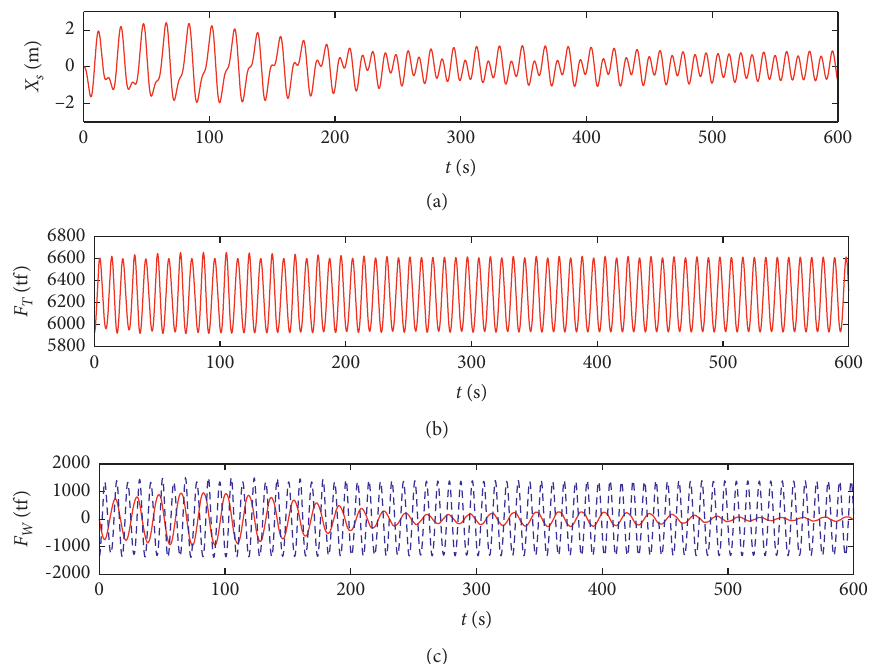
Figure 8: The time history of (a) tube displacement X s , (b) mooring cable tension F T , and (c) wave force F W (the solid line represents horizontal wave force and the dotted line represents vertical wave force) under wave period equal to 9.13s, wave steepness equal to 0.04, and BWR equal to